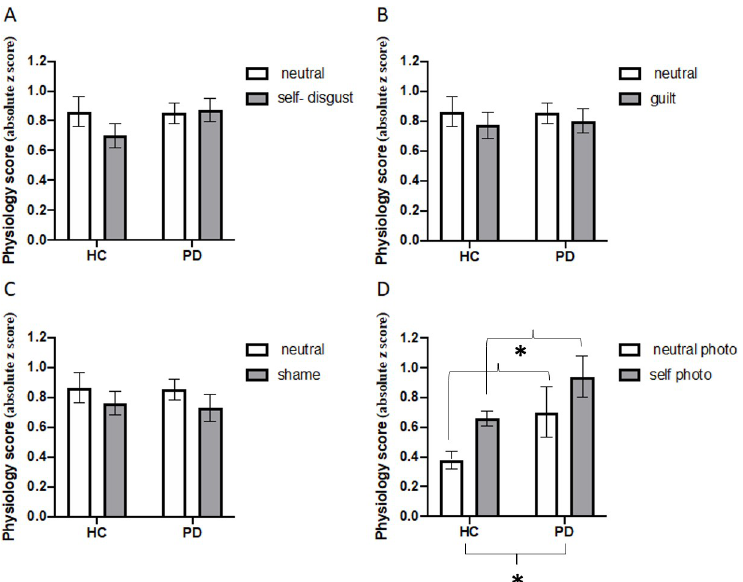
Fig 1. Composite physiology scores (szcores) as a function condition (emotion and neutral) and group (HC = Healthy Control, PD = Parkinson’s Disease patients). Panels A-C: Physiological response for self-disgust, guilt and shame narration paradigms, respectively. Panel D: Physiological responses for the photo paradigm (self- disgust induction). Error bars represent standard error, and asterisk significant differences (p < .05).